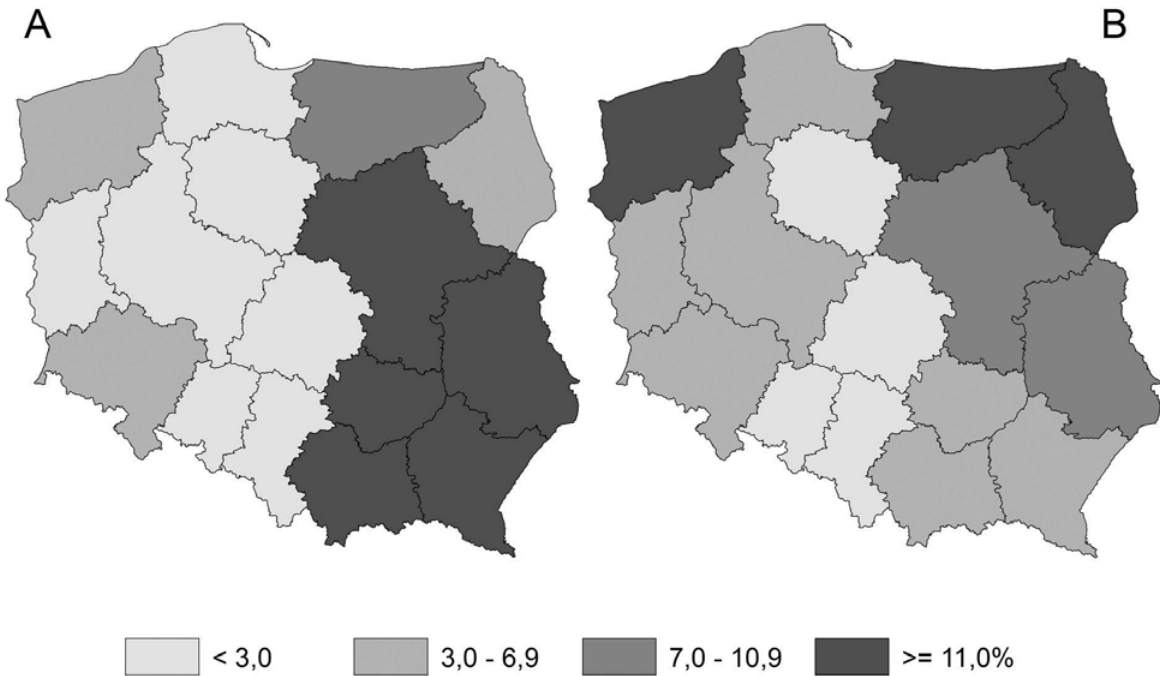
Fig. 4. Proportion of organic farms in the total number of farms in Poland by voivodeship, 2004 (A) and 2014 (B). Source: own calculations based on data from the Agricultural